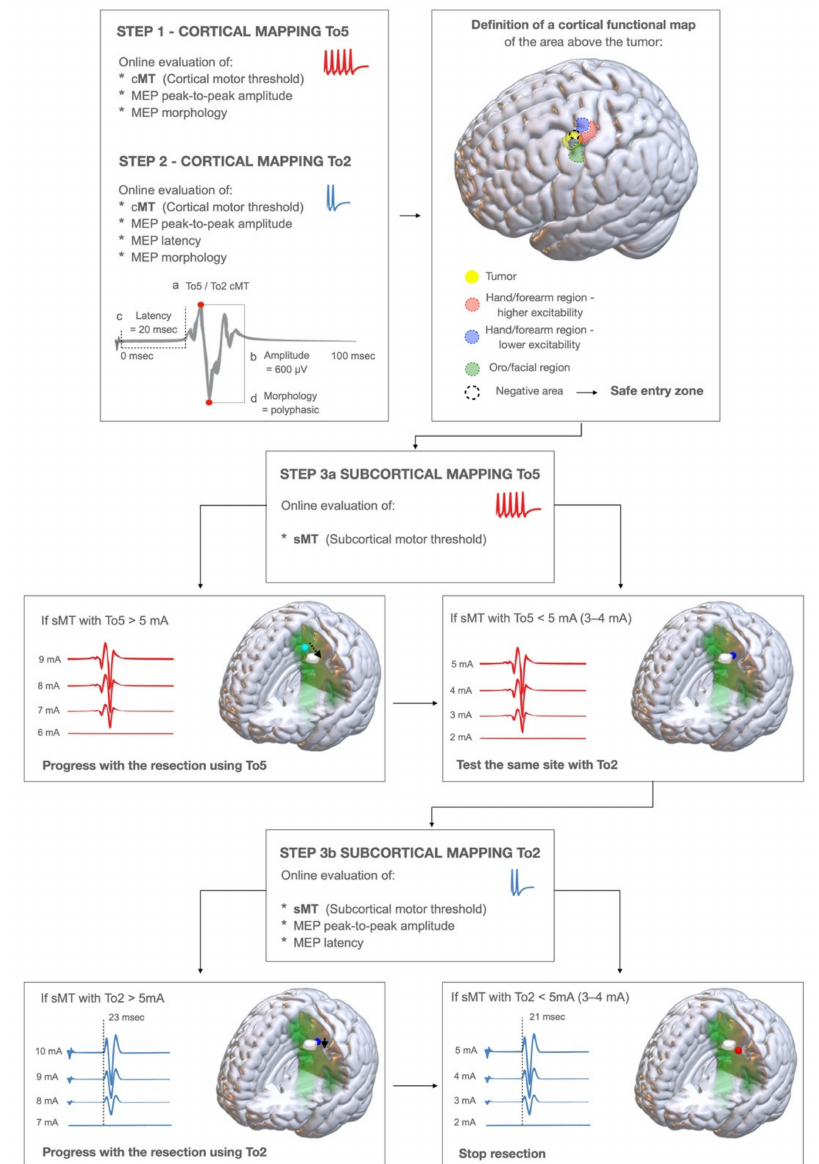
Figure 1. Steps of the brain mapping technique to detect the two functional components of M1. STEP1: a cortical mapping with HF-To5 paradigm is performed to explore the cortical area of interest. At each site (a) the cortical motor threshold (cMT), (b) the MEP peak-to peak amplitude, and (d) the MEP morphology are evaluated. See Figure S1 for practical insights on how to evaluate the peak-to-peak amplitude and MEP morphology. The Cortical Motor Threshold is defined as the lowest current intensity which is evoking the lowest MEP response. STEP2: the same sites are explored again with HF-To2, evaluating at each site: (a) the cMT, (b) the MEP peak-to-peak amplitude, (c) the MEP latency (evaluated from the first pulse artifact), (d) the MEP morphology. By performing this, we defined the cortical functional map, identifying: 1. The area of higher excitability, 2. The area of lower excitability, 3. The safe entry zone: the area where no MEPs are evoked (at current intensity > 20 mA, at HF-To2) or the area of lower excitability (see text). STEP3a: subcortical motor mapping initially performed with HF-To5. A continuous motor mapping is performed by placing the monopolar probe in the close vicinity of the resection site (suction) and coupled with it. At each site, the subcortical-MT (sMT) is continuously evaluated. If the sMT is > 5 mA, the resection is continued until sMT < 5 mA; in this case, the same site is explored by HF-To2 STEP3b: subcortical motor mapping with HF-To2; at each resection site, we evaluated (a) the sMT, (b) the MEP peak-to-peak amplitude, (c) MEP latency, (d) the MEP morphology. If the sMT > 5 mA, the resection is continued until the sMT is < 5 mA, and when sMT is 2–3 mA the resection is